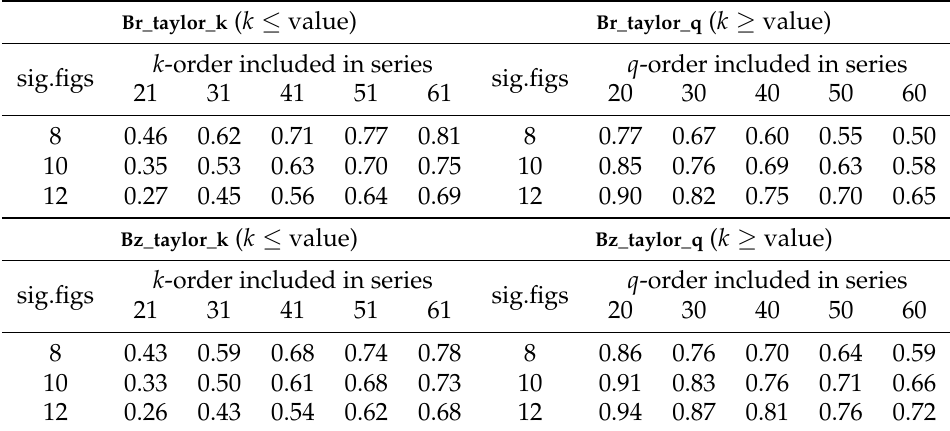
Table A1. Precision of various Taylor implementations in relation to the number of terms included in the respective